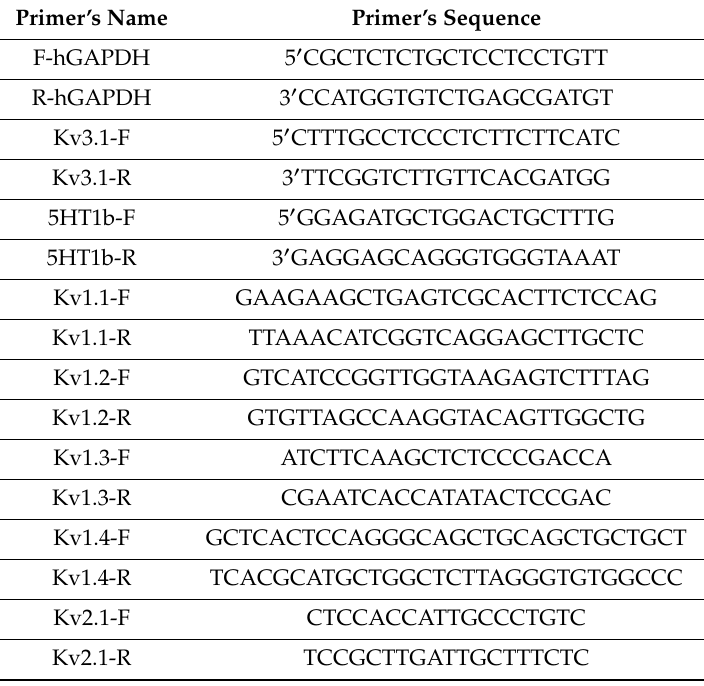
Table 2. The Primer Sequences used for PCR and qPCR